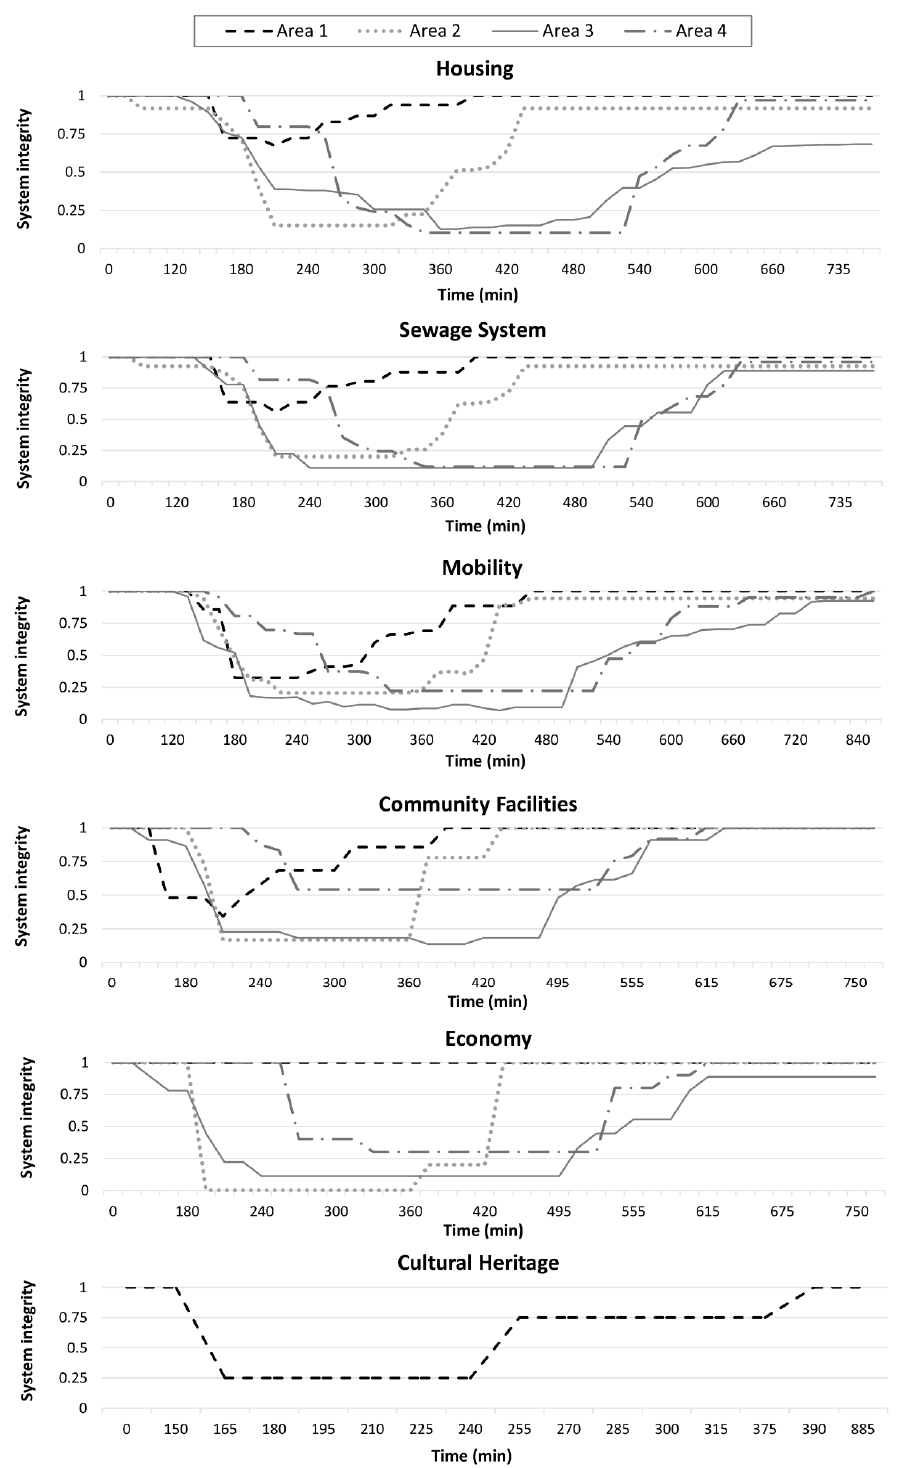
Figure 7. System Integrity Index graphs—Current Situation.